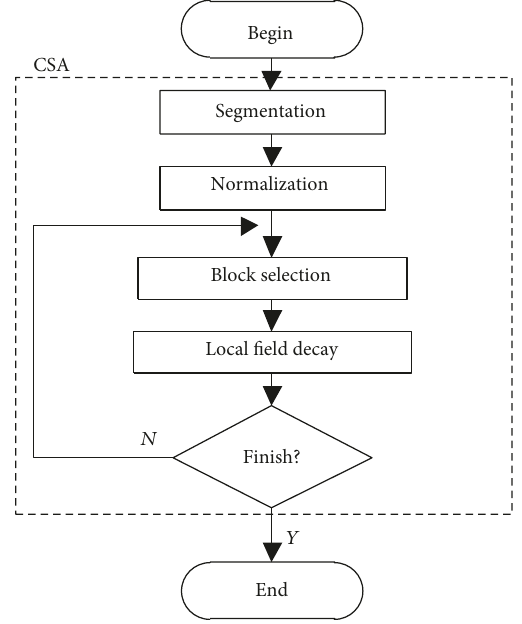
Figure 5: Diagram fl ow of